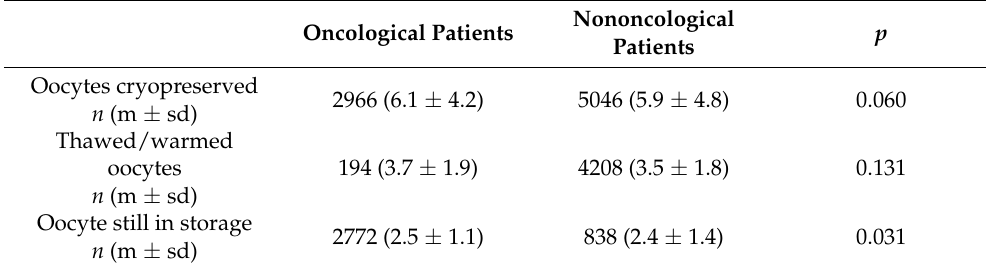
Table 4. Oocytes cryopreserved, thawed, or still stored in oncological vs. nononcological